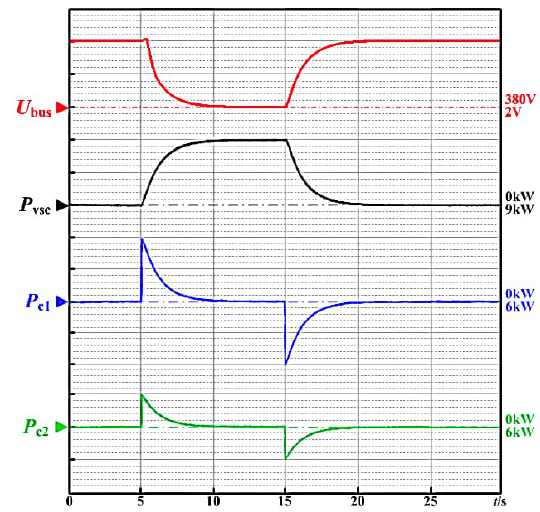
扫描全能王 创建 Figure 15. Experimental